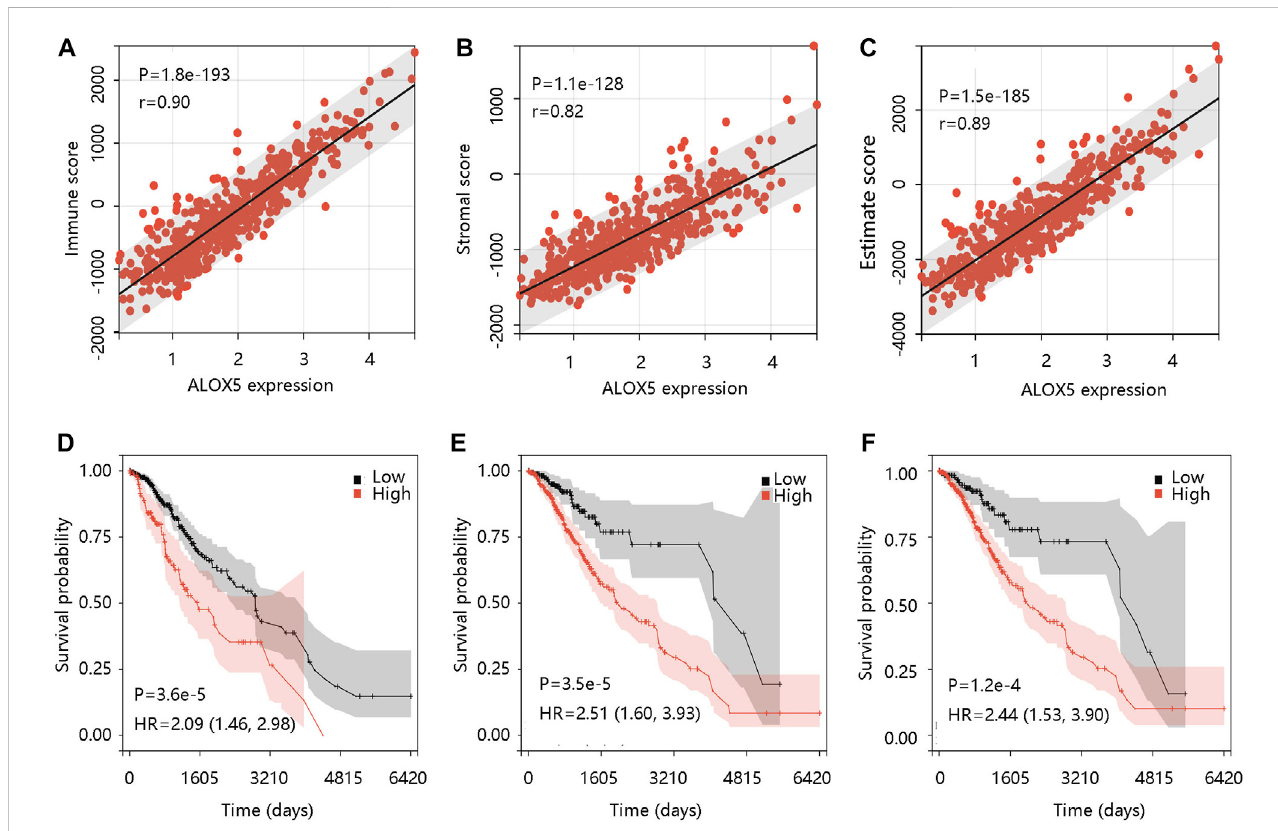
FIGURE 8 The immune cell in fi ltration analysis using ESTIMAE algorithm in TCGA-LGG data. The positive association of ALOX5 expression with (A) Immune score, (B) Stromal score, and (C) Estimate score. The correlation between the (D) Immune score-, (E) Stromal score-, and (F) Estimate score-based groups, and sample survival. HR, hazard